Question: Name the type of graph shown.
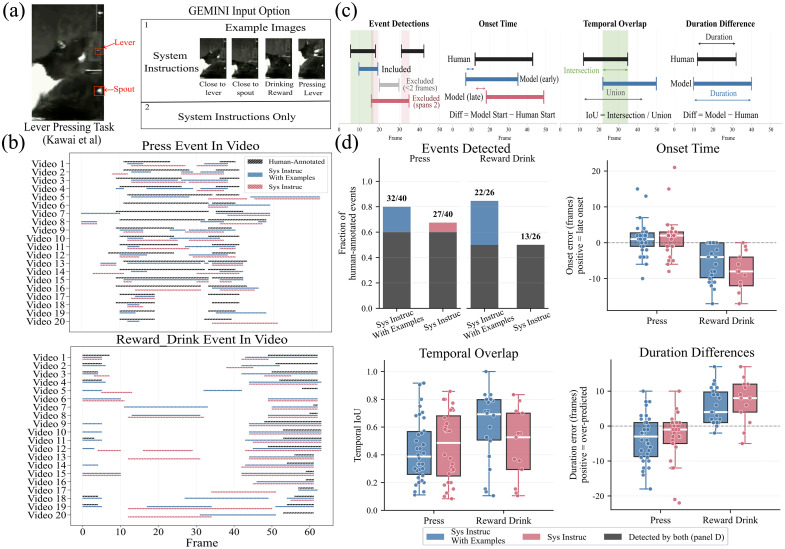
Answer: scatter